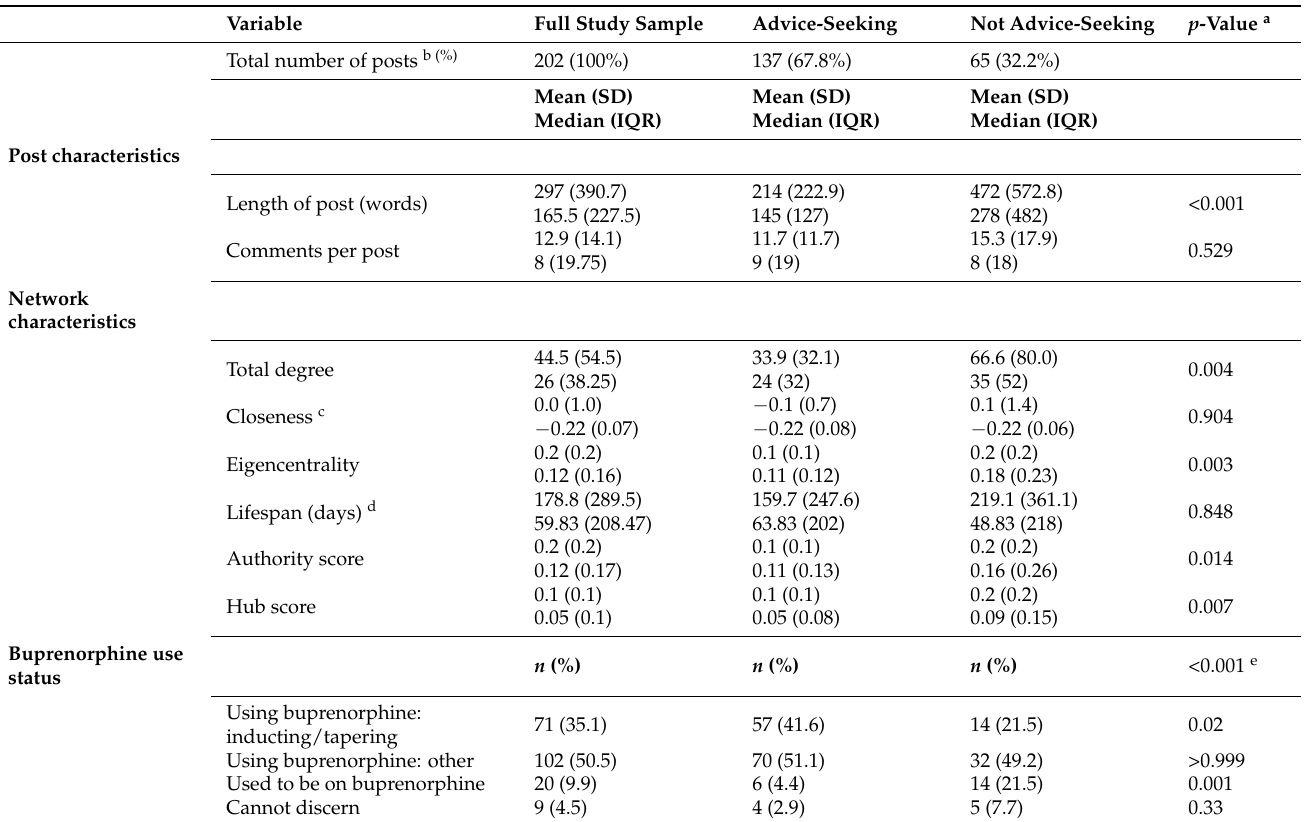
Table 1. Description of data with respect to post characteristics, network characteristics, and buprenor- phine use